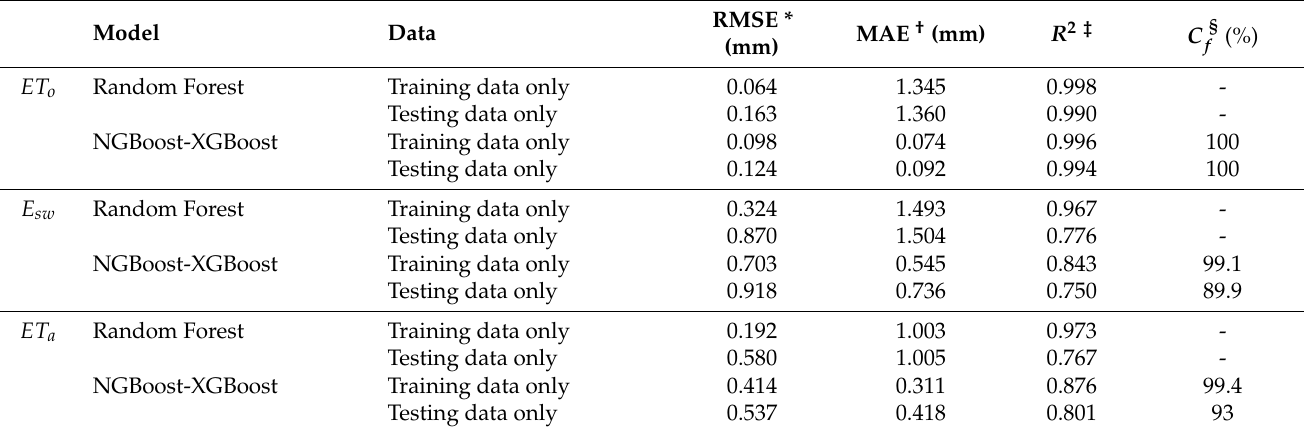
Table 1. Hybrid NGBoost-XGBoost ML model accuracy test with statistical measures and comparison to a baseline random forest